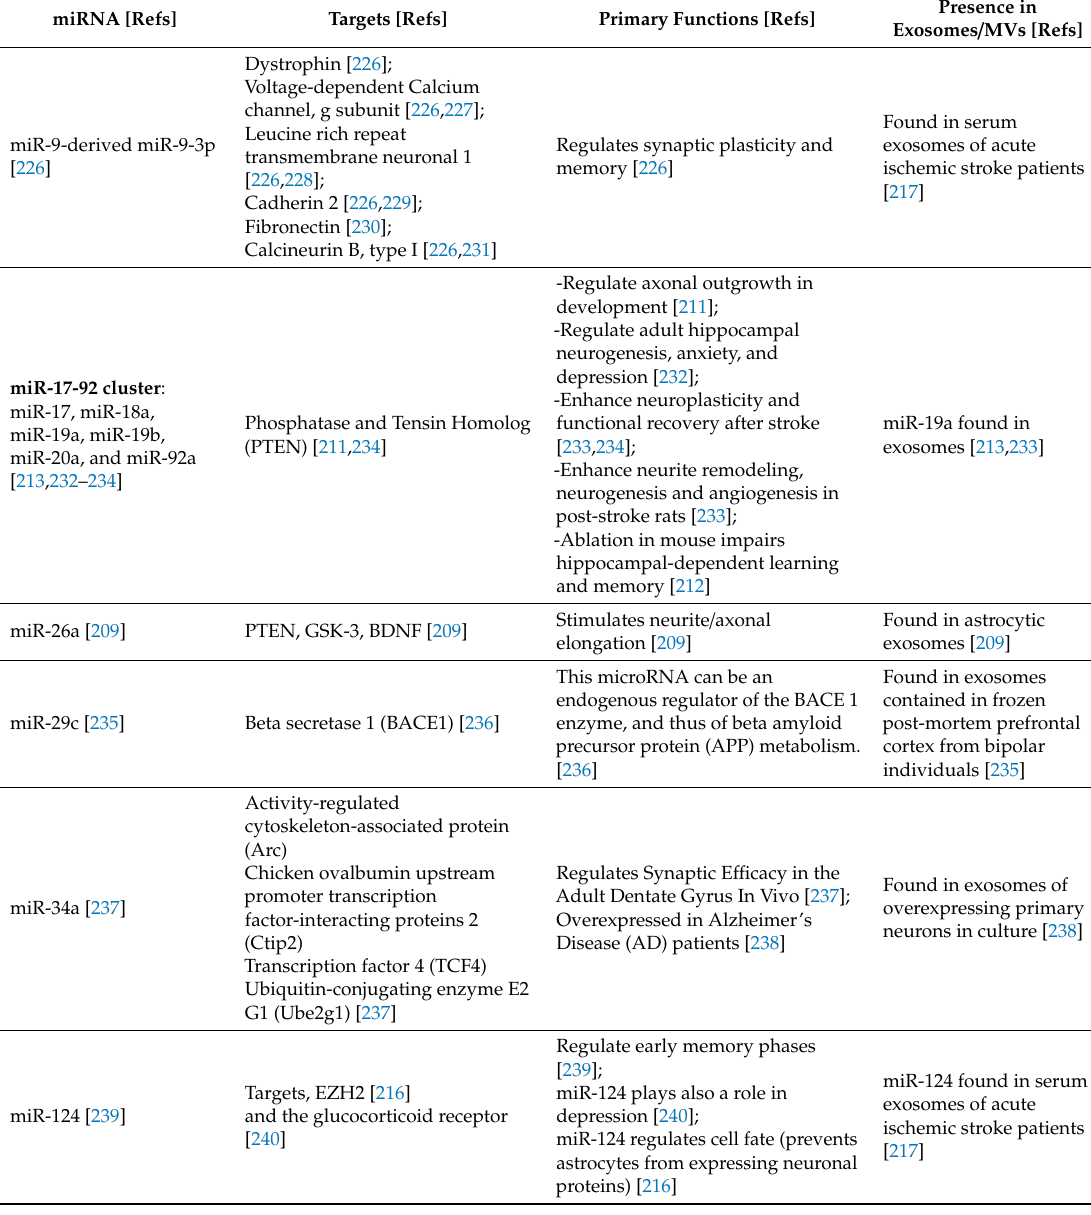
Table 1. Examples of miRNAs probably involved in learning / memory processes. References indicating their presence in extracellular vesicles are given in the last